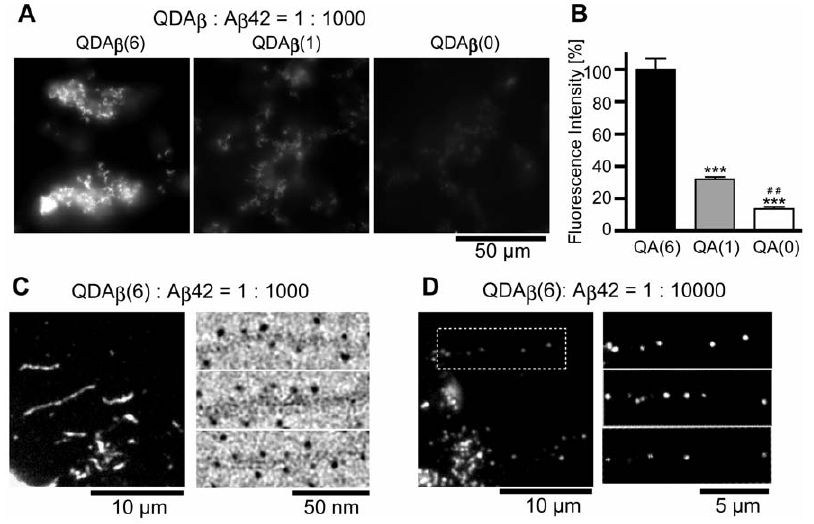
Figure 3. Coaggregation of intact A b 42 and QDA b . (a) 0.1% QDA b (6)- (left), QDA b (1)- (middle), and QDA b (0)- (right) containing A b 42 (final concentration 50 m M) were incubated in 96-well glass bottom plates at 37 u C for 1 day, and observed by wide-field fluorescence microscopy using a 100x objective lens with FITC filter set. (b) Fluorescence intensities of the aggregates in (a). Fluorescence intensities measured from 20 randomly selected fields (100 6 100 pixel: 8.6 6 8.6 m m) containing the aggregates are shown as relative % intensity against QDA b (6) group. *** denotes P , 0.001 for QDA b (6)- versus QDA b (1)- or QDA b (0)-samples and ## denotes 0.001 , P , 0.01 for QDA b (1)- versus QDA b (0) samples. Error bars indicate SD (n=20). (c) 0.1% QDA b -containing A b 42 (final concentration 50 m M). Samples were incubated in microcentrifuge tubes at 37 u C for 1 day, spread between glass slides and cover slips, and observed by regular microscopy using a 100x objective lens with QD filter set (left micrograph) and electron microscopy (right three micrographs). (d) 0.01% QDA b -containing A b 42 (final concentration 50 m M) were incubated in microcentrifuge tubes at 37 u C for 1 day, spread between glass slides and cover slips, and observed by regular microscopy using a 100x objective lens with QD filter (left micrograph). The right three micrographs are magnified and brightened micrographs. The top right micrograph is the boxed area in the left